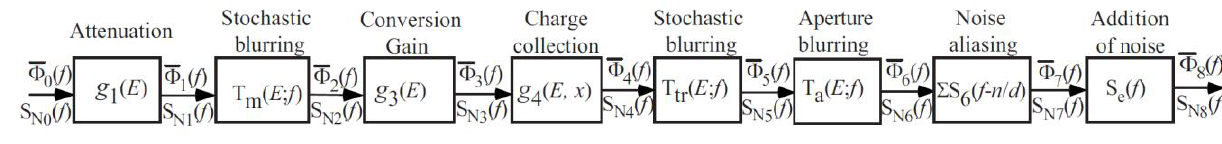
Figure 8. An example of one simple linear cascaded systems model recently used